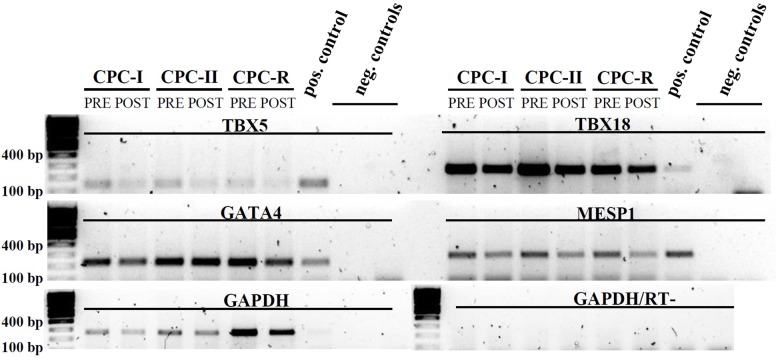
RT-PCR analysis of CPC cultured in different conditions. Mesodermal markers: TBX5 and TBX18; cardiac markers: GATA4 and MESP1. CPC samples were taken before (PRE) and after (POST) starvation for Exo production. Positive control: cardiac tissue. Amplification control: GAPDH. Negative controls (run in duplicate): reverse transcription negative sample with GAPDH primers. Gel images were cut above the primer dimers bands.